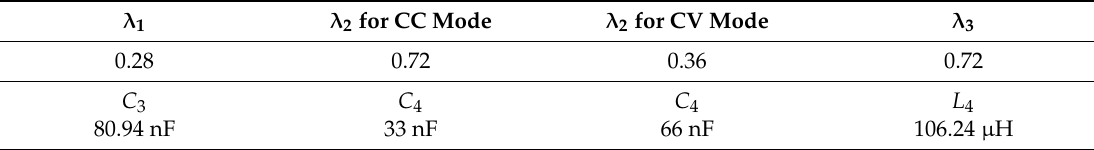
Figure 11. Two methods of charging mode conversion. Table 2. Theoretically calculated parameter values of first method.